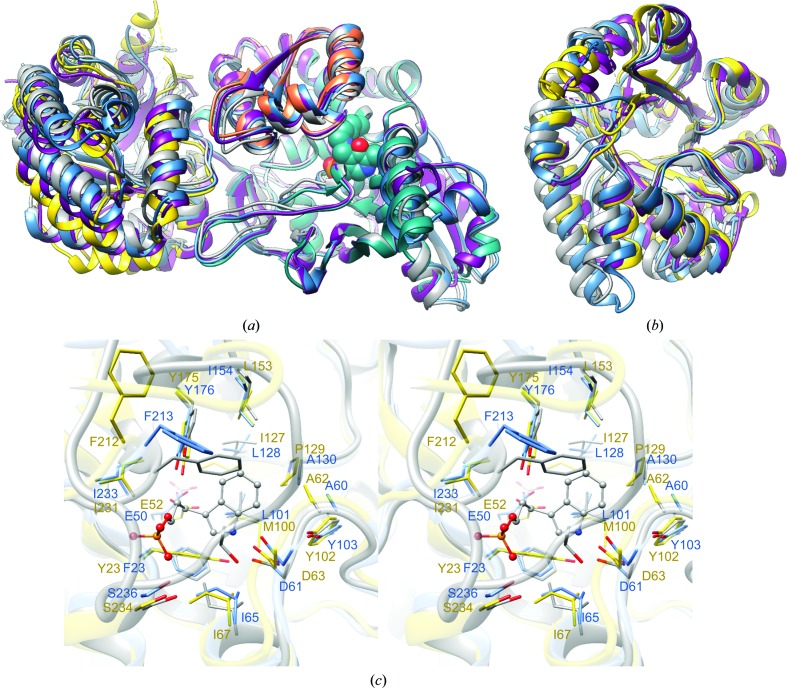
Comparison of TrpAB orthologs. (a) Superposition of SpTrpB (yellow, TrpA, chain C; coral/cyan, TrpB, chain D) with FtTrpB (blue), MtTrpB (purple; chains A and B; PDB entry 5tcf; Wellington et al., 2017 ▸) and StTrpB (gray; PDB entry 1bks; Rhee et al., 1996 ▸). PLP from SpTrpAB is shown in a sphere representation. TrpA is shown to indicate the mutual orientation of the subunits. (b) Superposition of TrpA extracted from the TrpAB heterodimers. (c) Stereoview of the TrpA active-site superposition of SpTrpA (yellow), FtTrpA (blue) and StTrpA in complex with IPP (gray; PDB entry 1qop; Weyand & Schlichting, 1999 ▸).